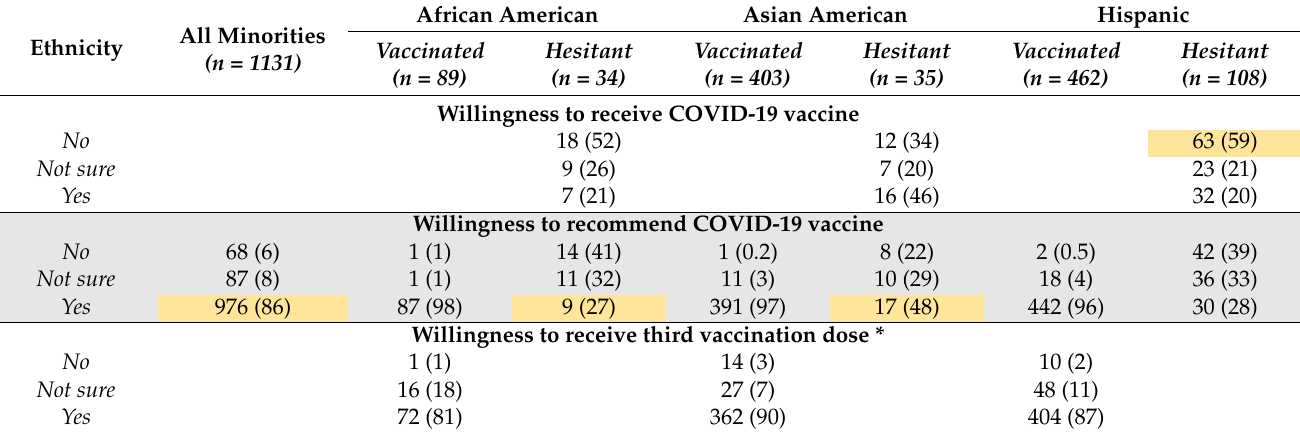
Table 3. Ethnic differences regarding COVID-19 vaccine hesitancy amongst health care workers. Results are reported as Count (Percent) in each column. Notable differences shaded in beige. *